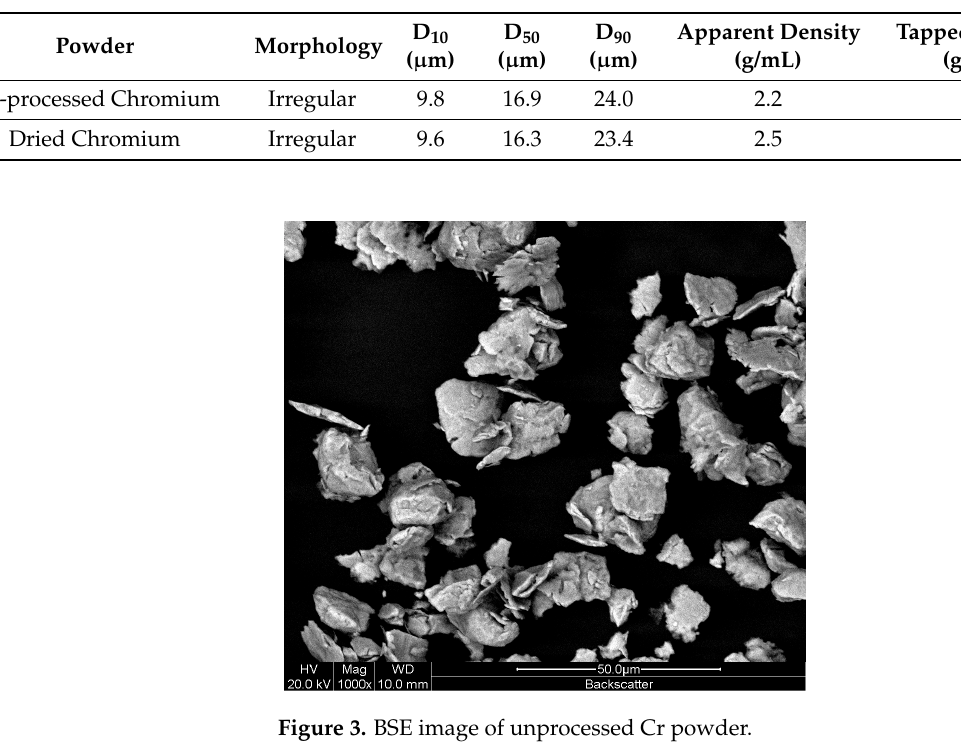
Table 3. General characterization metrics for the Cr powders considered in this study.